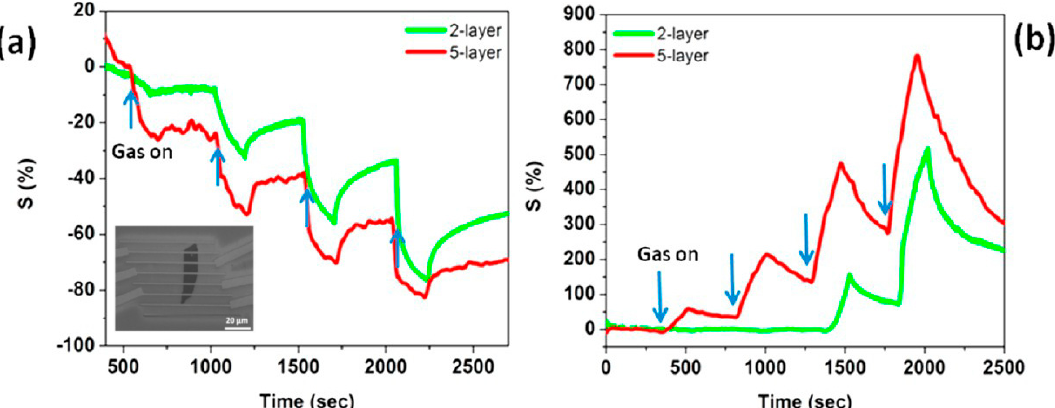
Figure 15. Sensing performances of 5-layers (red curve) and bilayers (green curve) MoS 2 sensing device to NH 3 (panel ( a )) and NO 2 (panel ( b )). Gas concentrations are 100, 200, 500 and 1000 ppm. Inset: SEM image of the 2-layer MoS 2 transistor device (scale bar 20 µ m). (Adapted with permission from [166]. Copyright 2013 American Chemical Society, Washington, DC, USA).